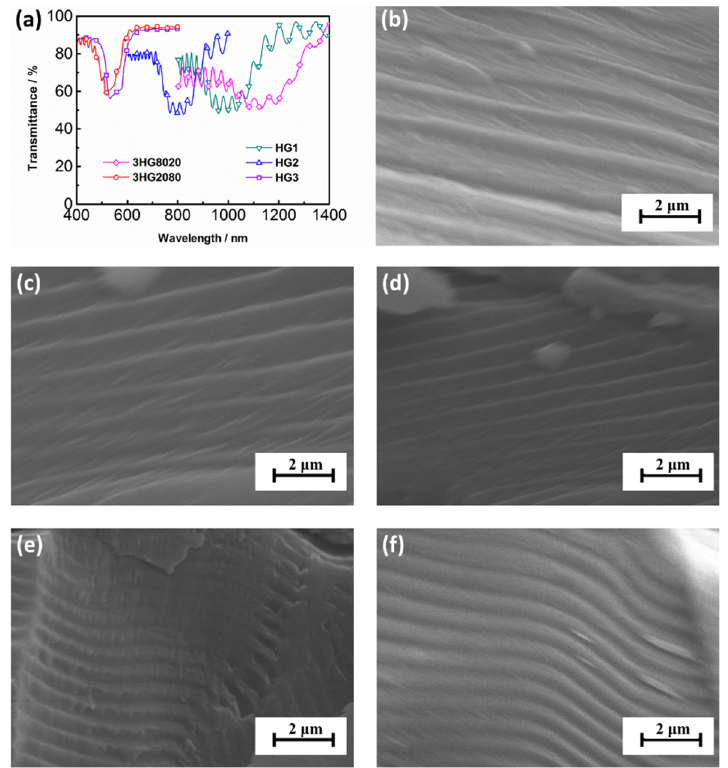
Figure 4. ( a ) The transmission spectra of the samples. Scanning electron microscopy micrographs of the polymers: ( b ) 3HG8020; ( c ) HG1; ( d ) HG2; ( e ) HG3; and ( f ) 3HG2080.